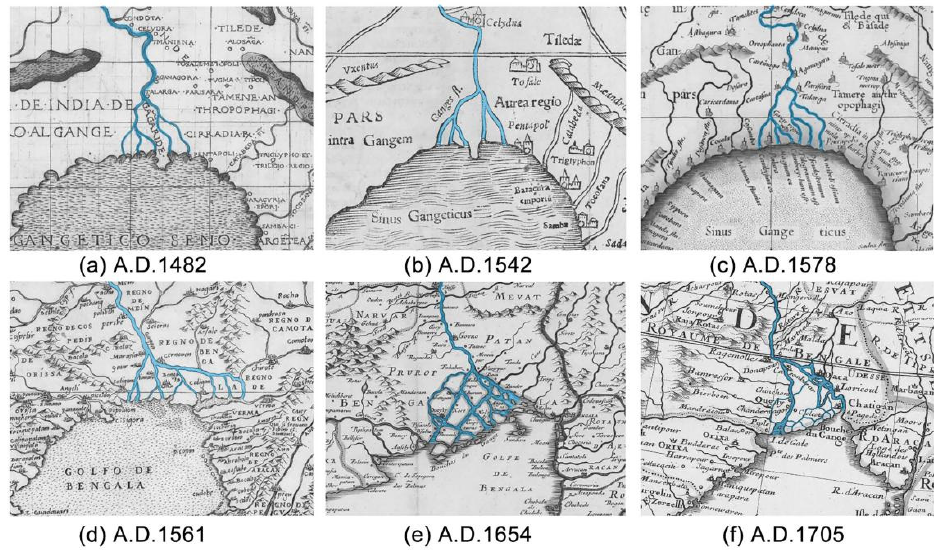
Figure 6. Change in the lower Ganges River channels on European maps from A.D. 1482 to A.D.